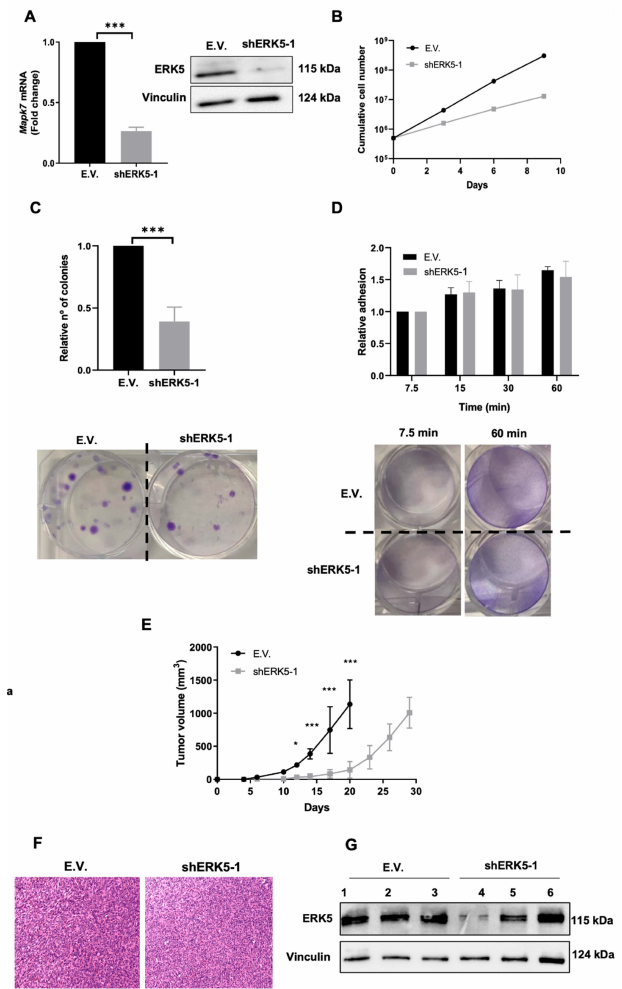
Figure 4. ERK5 modulates in vitro and in vivo growth of 3MC-C3 cell line. ( A ) 3MC-C3 cells were infected with lentiviruses carrying PLKO.1 empty vector (E.V.) or the PLKO.1-shRNA ERK5-1 vector (shERK5-1). Interference was evaluated by RT-qPCR using β -2-microglobulin (B2m ) as an endogenous control (left panel). E.V. cells were considered as 1. Right panel shows a representative image of the interference by western blot using vinculin as a loading control. ( B ) For growth curves, 3 × 10 5 E.V. or shERK5-1 3MC-C3 cells were seeded in 100 mm plates. Every 3 days, cells were counted and replated in the same manner up to day 9. Graphic shows the cumulative cell number from a representative experiment out of 3 with nearly identical results in different pools of infections. ( C ) Upper panel: Relative number of colonies obtained in clonogenic assays of E.V. and shERK5-1 3MC-C3 cells. Lower panel: Representative image of a colony formation assay from both cell lines. ( D ) Upper panel: Relative adhesion of E.V. or shERK5-1 3MC-C3 cells was assessed by crystal violet staining at the indicated time points. Lower panel: Representative image of adhesion assays at 7.5 and 60 min. ( E ) Nude mice (n = 4) were inoculated with 5 × 10 5 cells of each cell line derived from 3MC-C3, and tumorigenesis was analyzed at indicated times. Graphics represent the mean ± SD. Final tumor weight for E.V.-derived tumors was 0.27 g ± 0.17 and for shERK5-1-derived tumors was 0.26 ± 0.09). The experiment was performed by using another pool of infection with nearly identical results. ( F ) Western blot analysis of the expression level of ERK5 in tumors recovered from 3MC-C1 E.V. and shERK5-1. Vinculin was used as a loading control. ( G ) Representative images of the histological study of tumors obtained from 3MC-C3-derived cell lines. Pictures are shown at a 20 × magnification. The graphs/histograms represent the mean ± SD of 3 independent experiments performed in triplicate cultures with different pools of infections, if not otherwise indicated. Original blots could be found in Figure S7. * p < 0.05; and *** p <